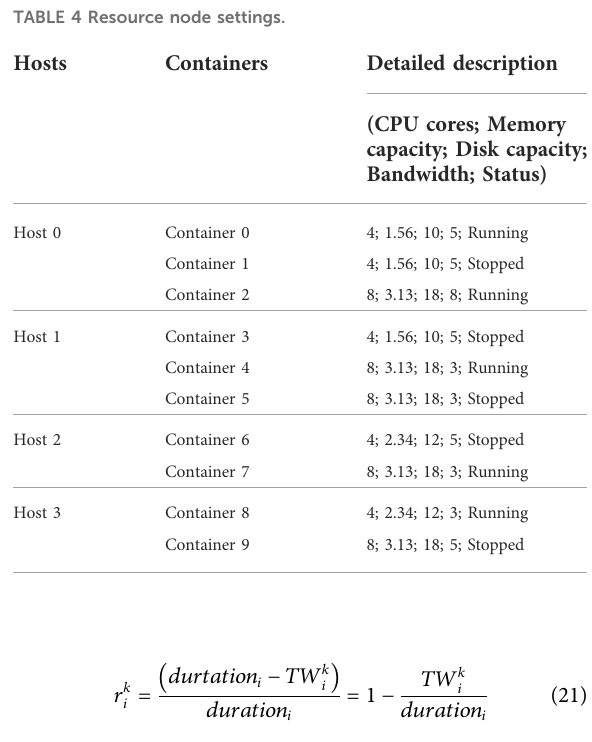
TABLE 4 Resource node